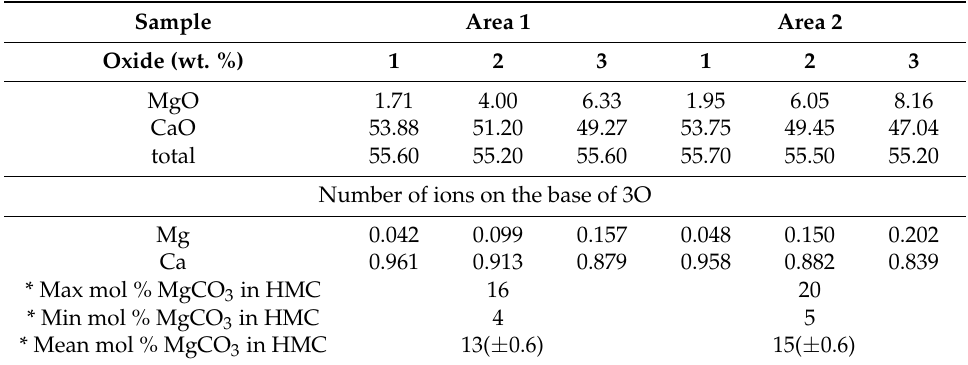
Table 3. Representative BSE-EDS analysis of cement phase of studied samples. Calculated values of mol % MgCO 3 in cement phase. HMC: high-magnesium